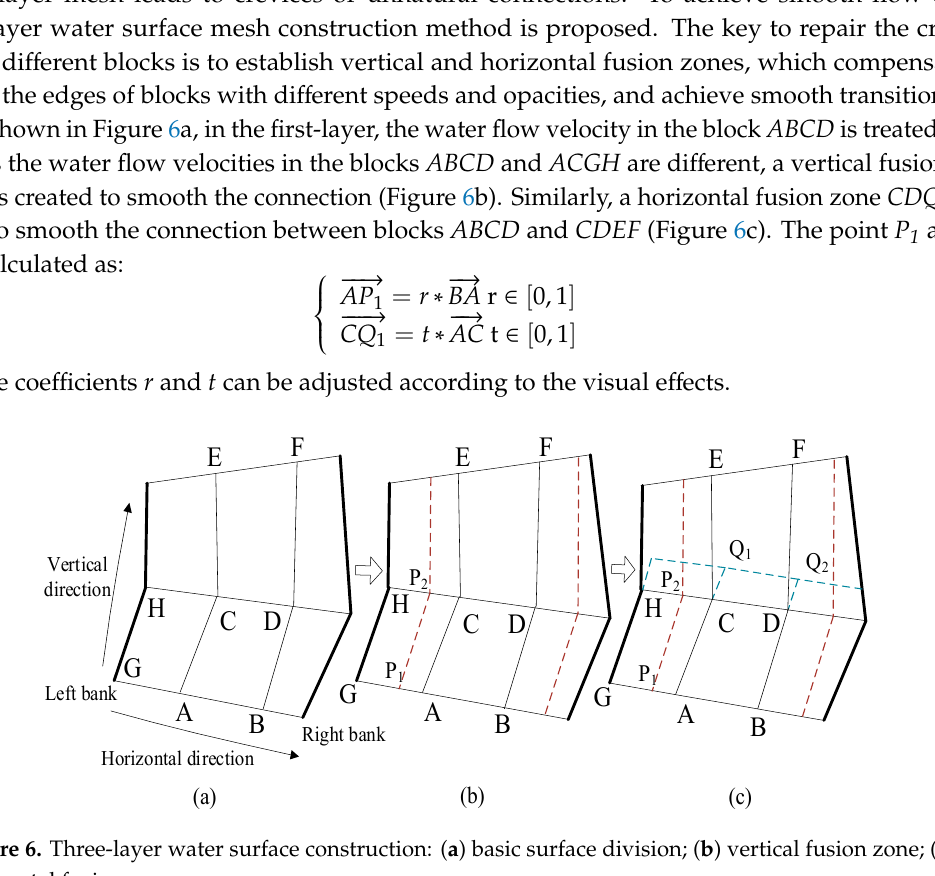
(b) Figure 7. Dynamic texture mapping: ( a ) water surface mesh; ( b ) texture mapping. The specific texture coordinate calculation includes four parts: (1) Static texture coordinate calculation. The texture coordinates of each vertex are calculated to map water texture on the river surface mesh. Here, (U, V) denotes the texture coordinates, where the U axis is along the cross-section, and the V axis is along the main flow direction and perpendicular to